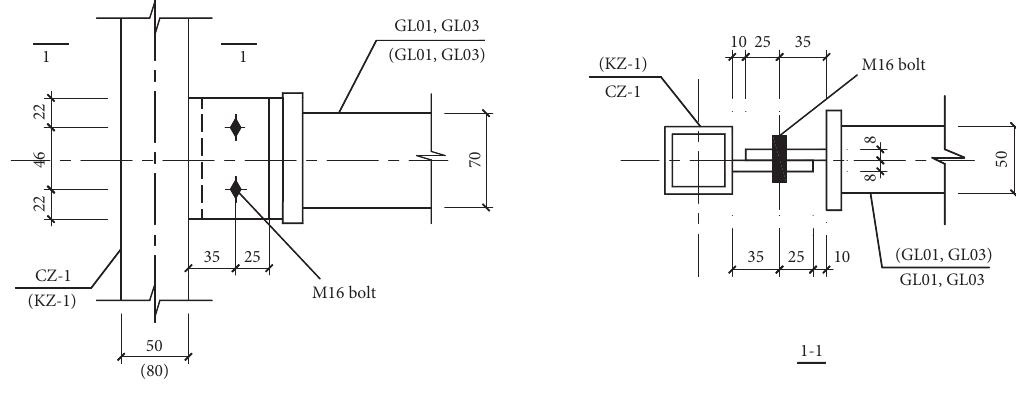
Figure 9: Beam-column